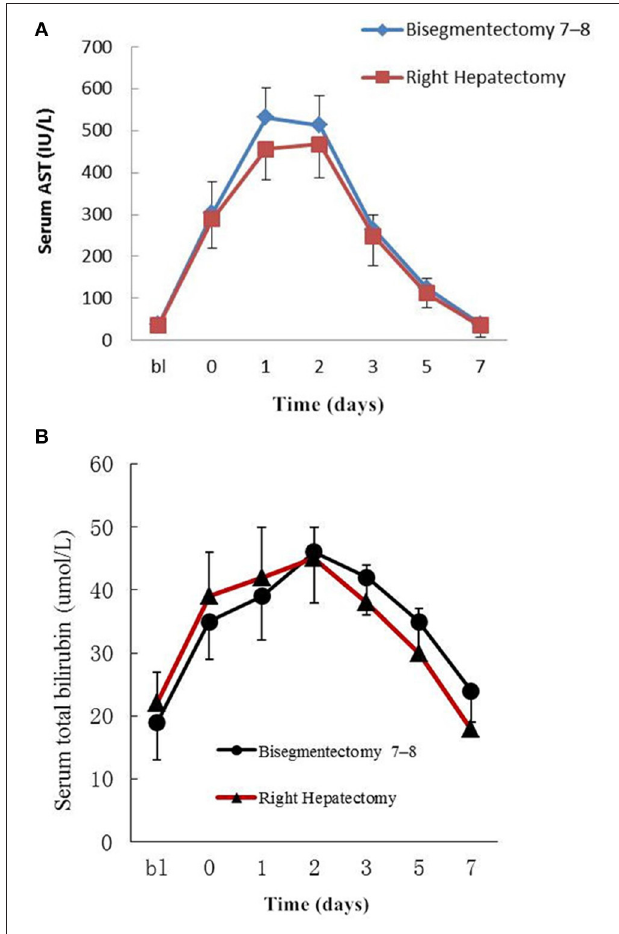
FIGURE 2 | (A) Peri-operative changes of serum AST. bl: Preoperative value as baseline; 0–7: Postoperative days; Data are mean ± SEM. P = 0.054. (B) Peri-operative changes of serum total bilirubin. bl: Preoperative value as baseline; 0–7:Postoperative days; Data are mean ± SEM. P =